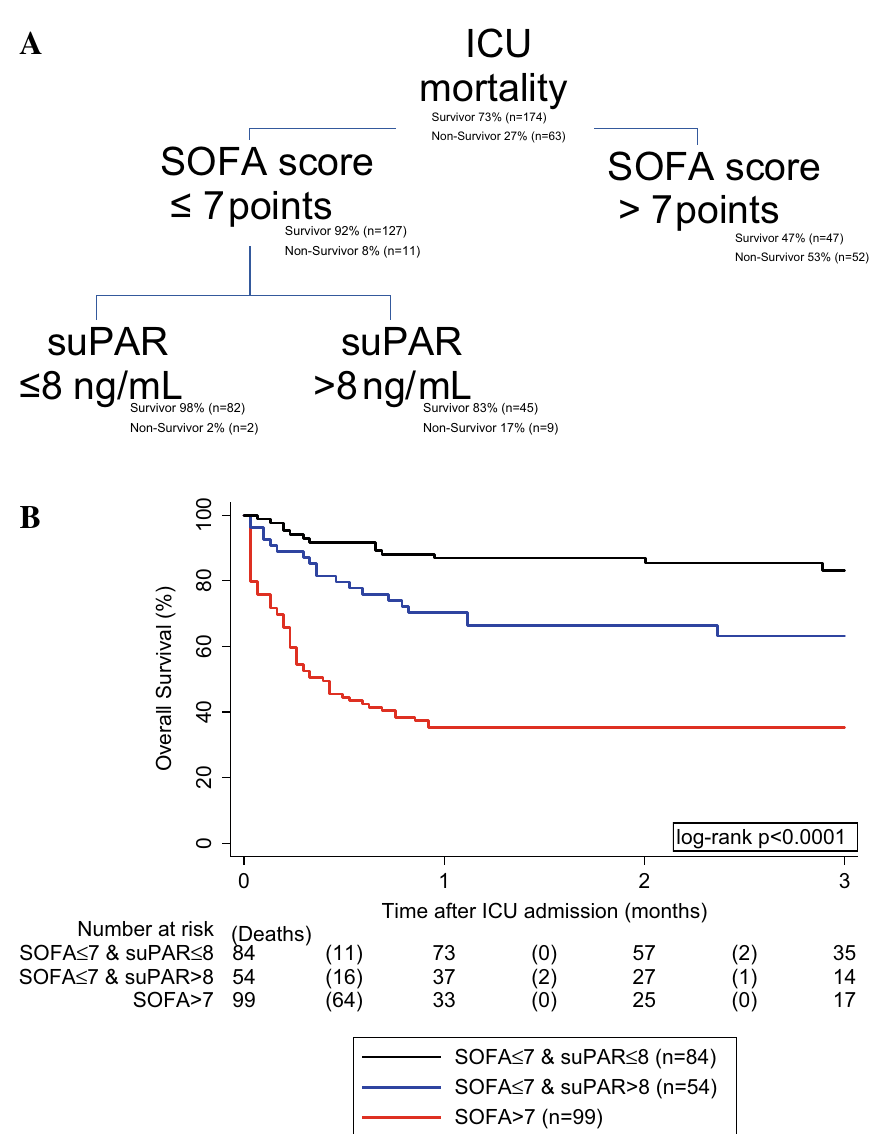
Figure 4. ( A ) Random forest analysis—overall survival according to risk stratification groups. For this analysis, we used the random forest machine learning method with the CHAID algorithm treating ICU mortality as a dependent variable and suPAR and SOFA score as independent variables, with tenfold cross validation. The random forest proposed cut-off values for SOFA score at 7 points (corrected p < 0.0001) and for suPAR at 8 ng/ mL (corrected p = 0.022). Note that in patients with a SOFA score > 7 the prognosis was determined solely by the SOFA score. ( B ) Random forest analysis – Overall survival according to risk stratification groups. ICU mortality was 53% in patients with a SOFA score > 7 points (n = 99), 17% in patients with a SOFA score ≤ 7 points and suPAR levels > 8 ng/mL (n = 54), and 2% in patients with a SOFA score ≤ 7 points and suPAR levels ≤ 8 ng/mL (n = 84). Log-rank p <